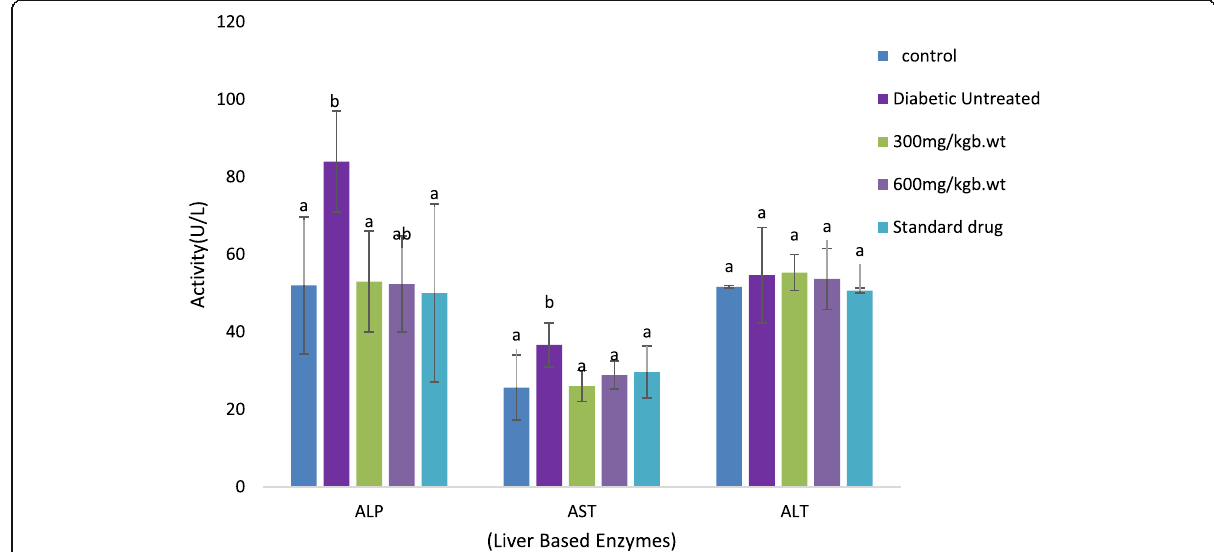
Fig. 2 Effect of Methanol Root Extract of Chromolaena odorata on Liver based enzymes (ALP, AST, and ALT) in Alloxan Induced Diabetic Rats. Each bars represents Mean ± SEM of triplicate determinations. Bars with different alphabets indicate significant difference at ( p < 0.05). ALP- Alkaline Phosphatase, AST-Aspartate Aminotransferase, ALT-Alanine Aminotransferase